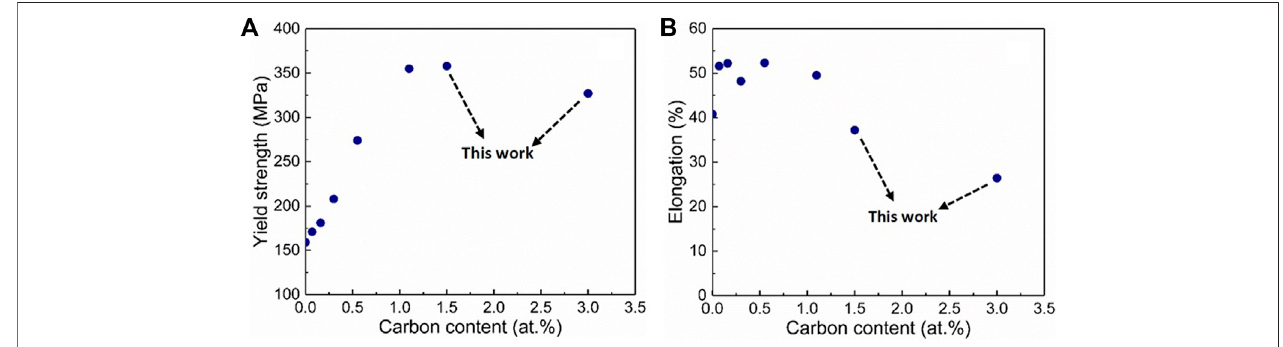
FIGURE 8 | Kernel average misorientation maps of (A) CR1, (B) CR2, (C) HT1, and (D) HT2 alloys.